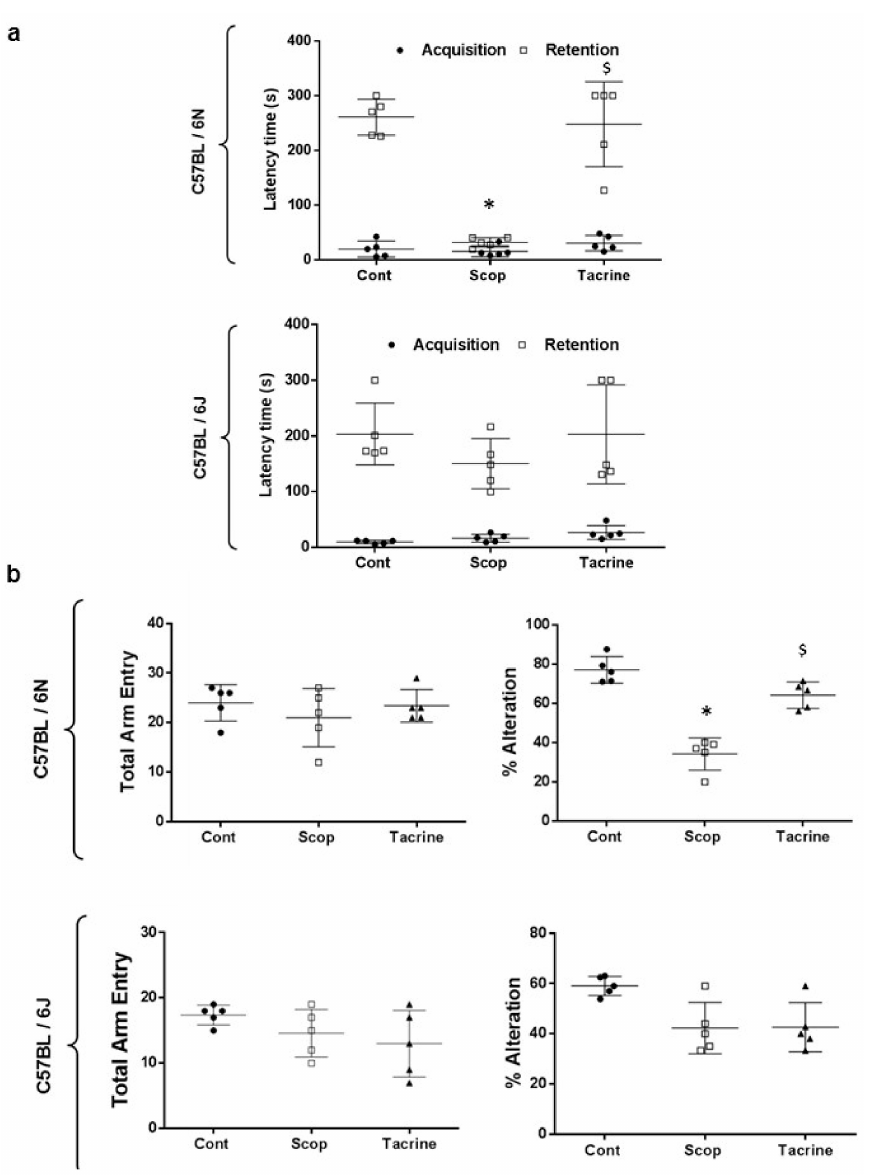
Figure 3. Spatial learning and memory analysis comparison of C57BL/6 substrains—C57BL/6N and C57BL/6J in scopolamine-induced amnesic model: ( a ) Step-through passive avoidance test—latency time variance during acquisition and retention; ( b ) Spontaneous alternation performance (Y-Maze test)—number of arm entries and percentage of alternation (circle dots—control group; square—scopolamine group; triangle represents tacrine group). Tacrine (10 mg/kg) was used as positive control. Data are expressed as mean ± SD ( n = 5). One-way ANOVA-Tukey’s multiple comparison test was performed where, * p < 0.05 scopolamine compared with the control group; $ p < 0.05 tacrine compared with scopolamine-treated